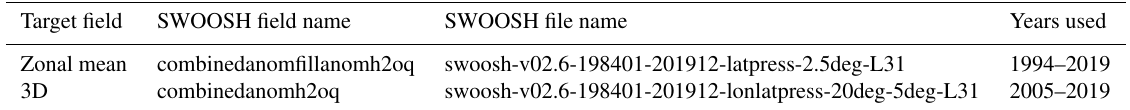
Table 1. Description of the target used in this analysis.